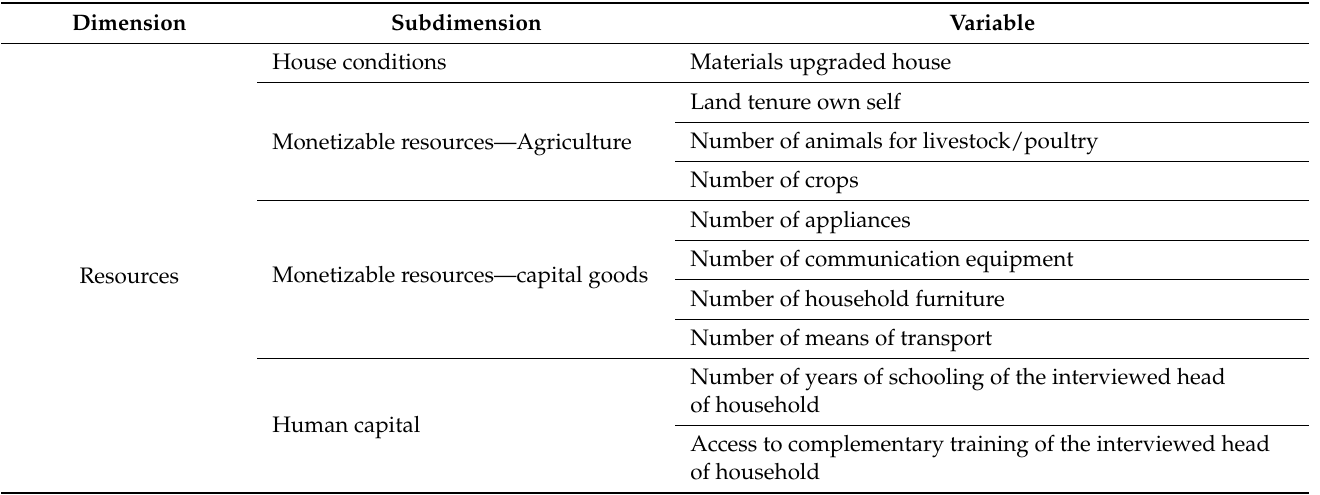
Table 1. Variables of the Multidimensional Poverty Index for the communities of the Tupiza River Basin.